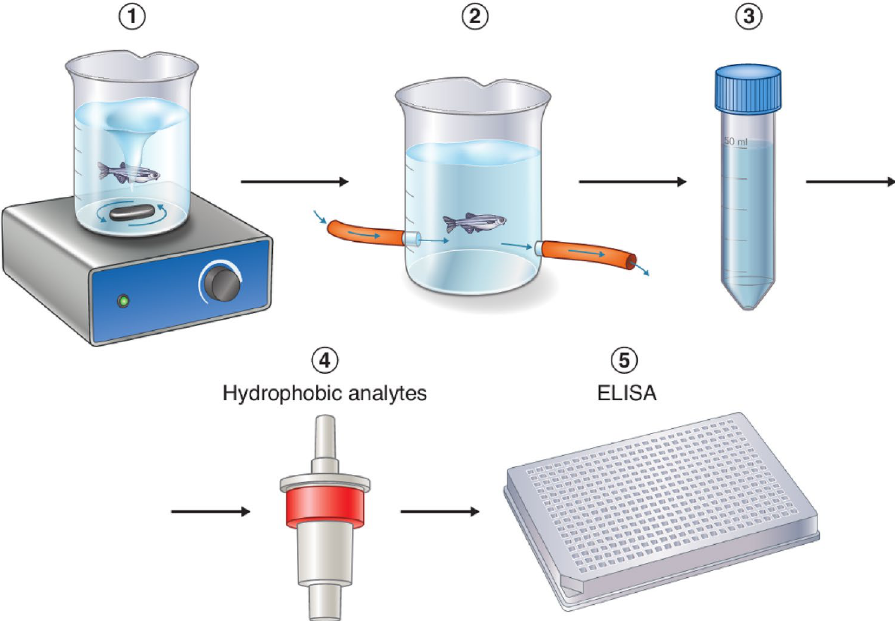
Figure 1. Experimental and analytical protocol for analysis of water-borne cortisol. (1) Fish were stressed in a glass beaker containing a stirring magnet and placed on a magnetic stirrer running at 100 RPM (2) before transferred to a plastic beaker connected to a flow-in and flow-out tube where water flow was shut off to allow cortisol to exit into the water. (3) Outflow water was then collected in 50 mL Falcon tubes (4) and cortisol extracted using C18 solid-phase extraction cartridges. (5) Water cortisol extractions were assayed using a commercial ELISA